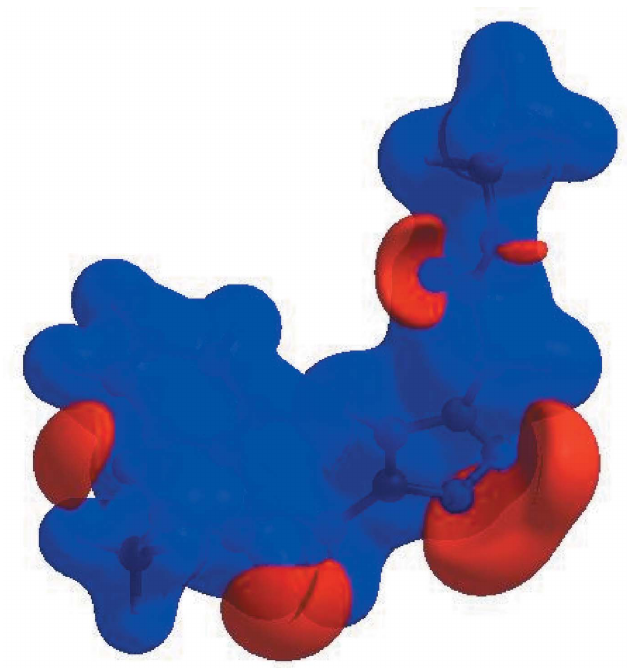
Figure 5 View of the three-dimensional Hirshfeld surface of the title compound plotted over electrostatic potential energy in the range (cid:4) 0.0500 to 0.0500 a.u. using the STO-3 G basis set at the Hartree–Fock level of theory. Hydrogen-bond donors and acceptors are shown as blue and red regions around the atoms, corresponding to positive and negative potentials, respectively.